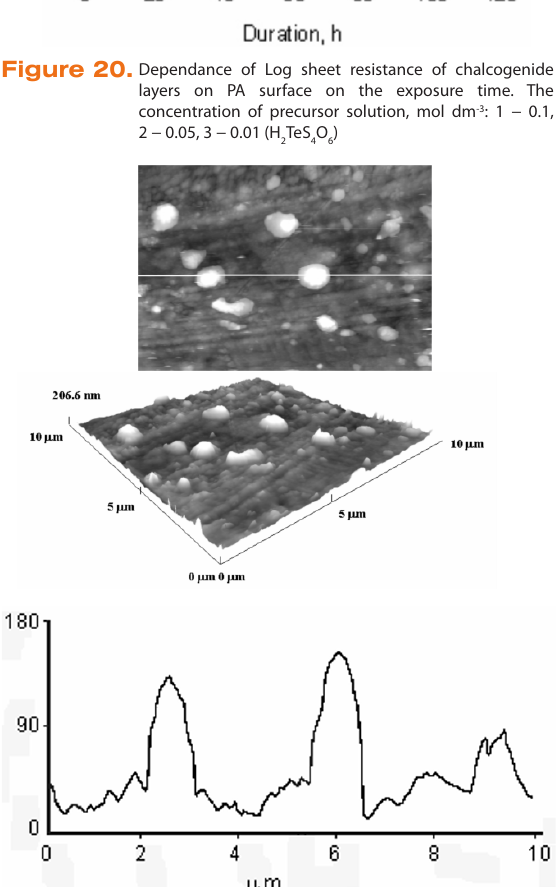
Figure 21. AFM top view of the layers of copper chalcogenides